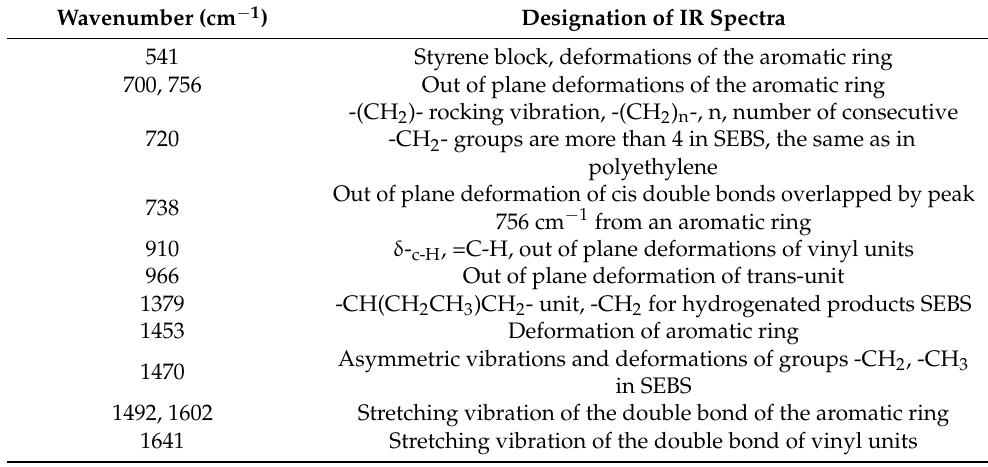
Table 2. Characteristic peaks, corresponding groups, and vibration types of